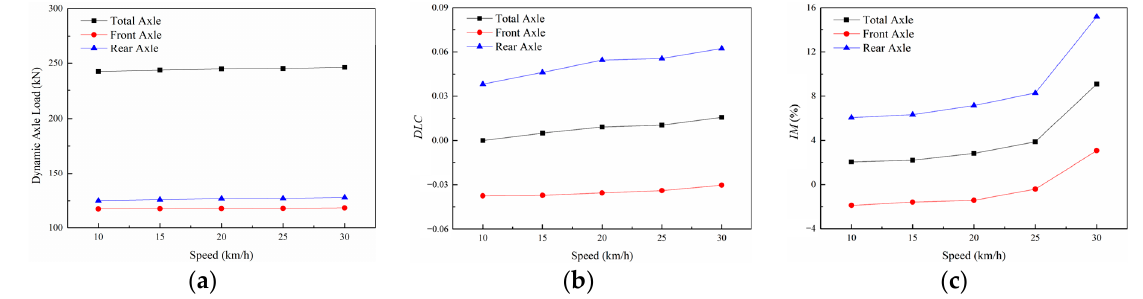
Figure 14. Dynamic axle load in curved road sections with different speeds under simulation conditions. ( a ) Dynamic axle load. ( b ) DLC . ( c ) IM .